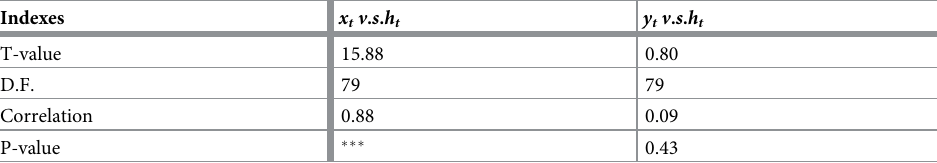
Standard errors are in